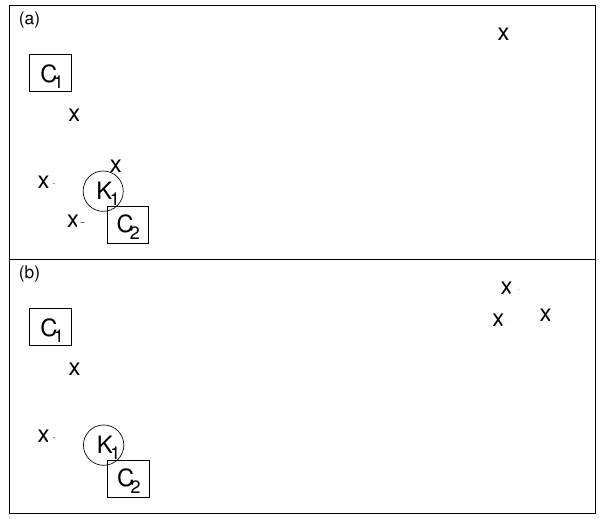
Figure 1. Example of two nowcast situations. Crosses indicate a lightning stroke, squares marked with a C indicate CellMOS cells and circles marked with a K indicate KONRAD